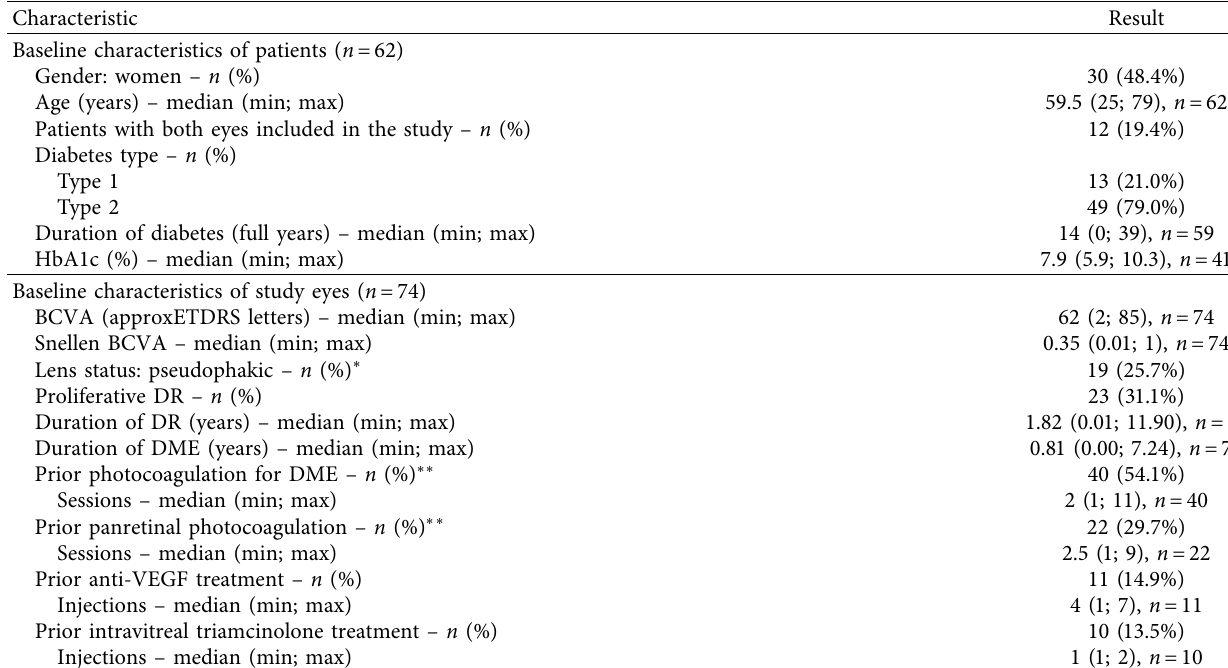
Table 1: Baseline characteristics of patients and study eyes.